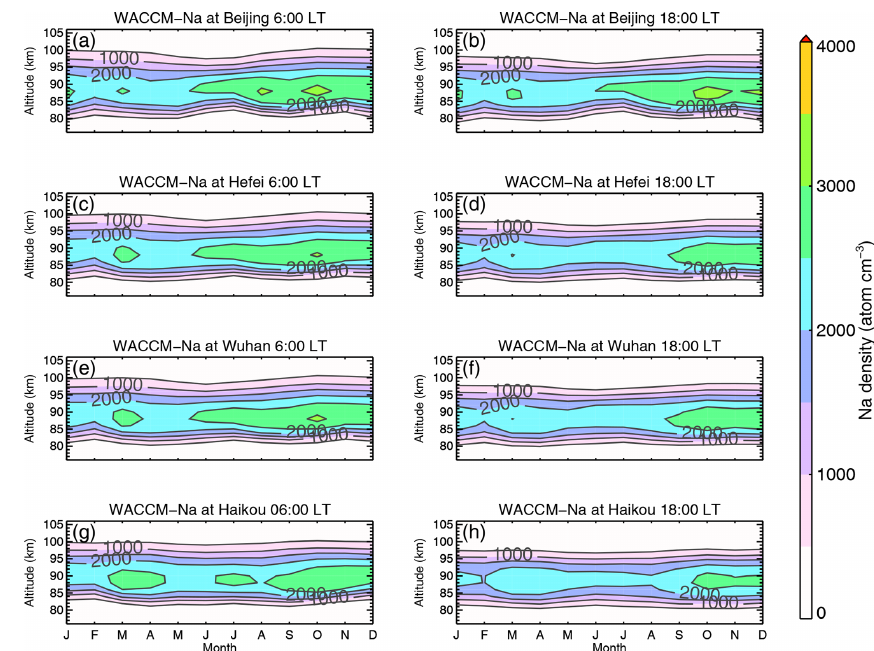
Figure 12. Monthly mean of the WACCM simulated Na number density in the morning at 06:00LT and in the evening at 18:00LT (a–b) at Beijing, (c–d) Hefei, (e–f) Wuhan, and (g–h) Haikou.